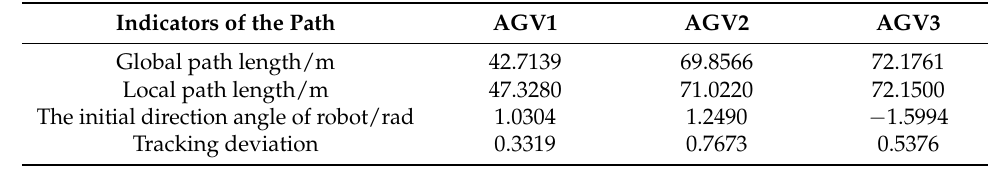
Figure 25. Multi-robot path planning 3. ( a ) Global path planning. ( b ) Robot local motion.